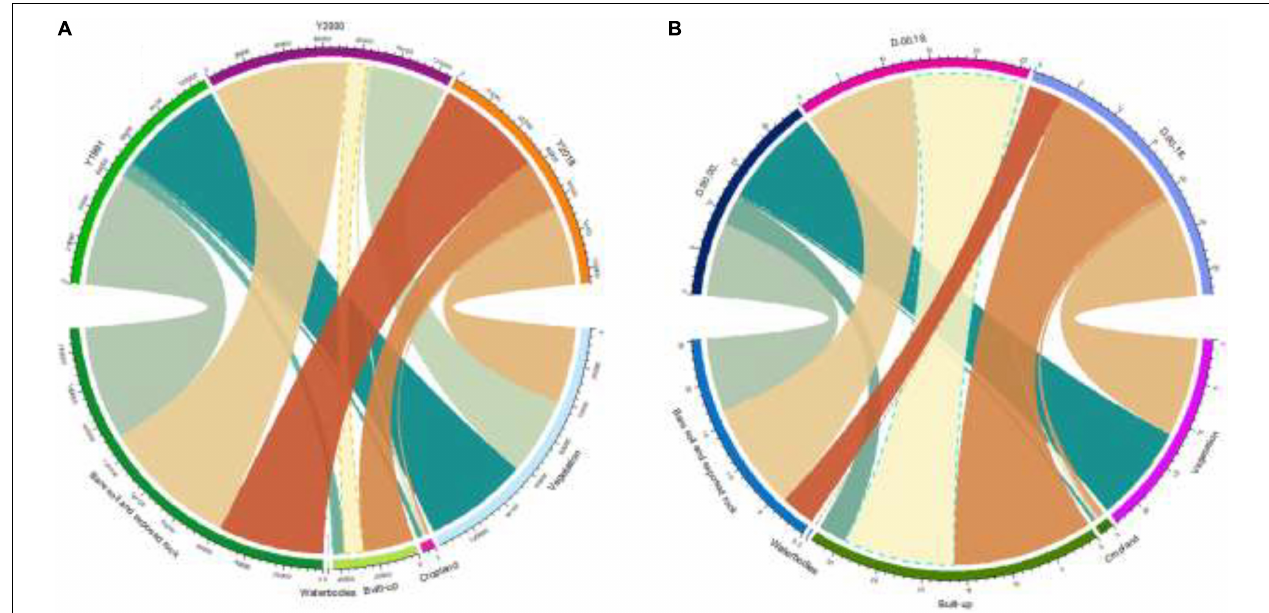
FIGURE 4 | Land use land cover dynamics analysis during the period of 1990–2020 using (A) absolute change, and (B) delta change (%).